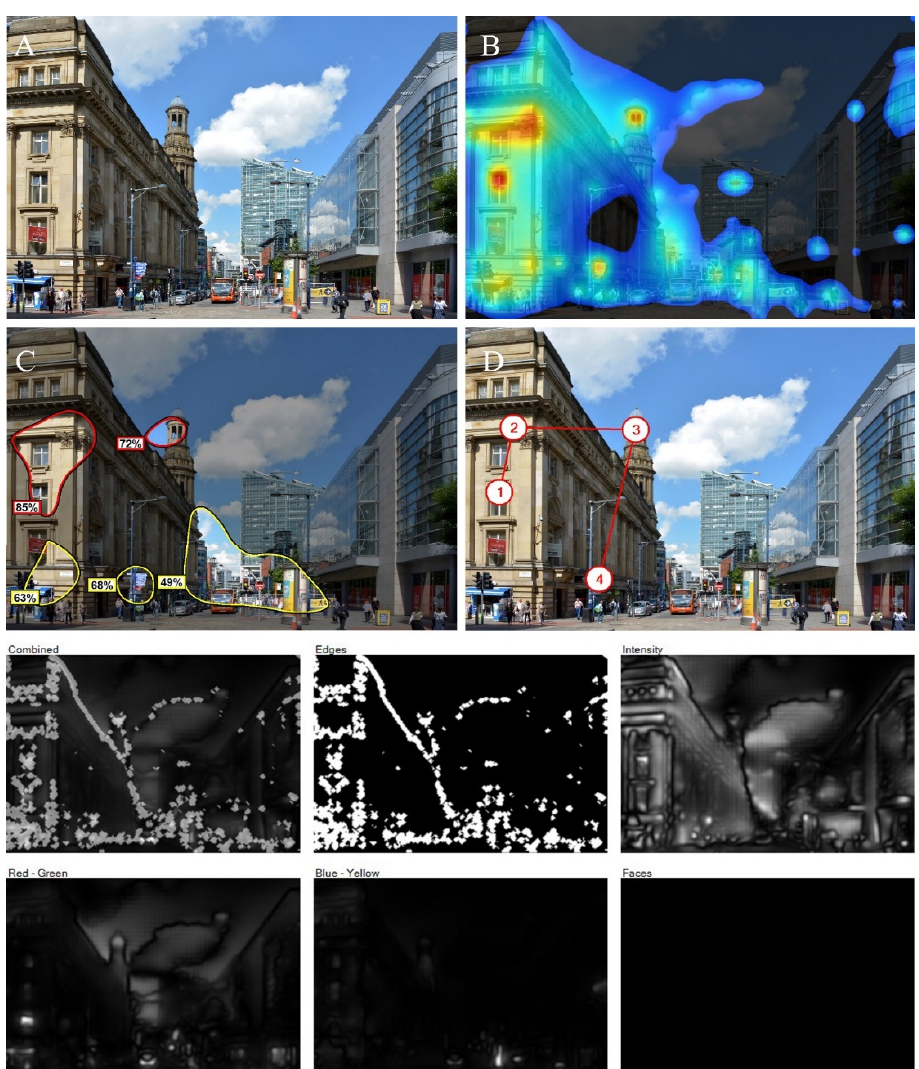
Figure 1. Image from the center of Manchester, UK, at the junction of Market and Cross Streets, with the full analysis output of the 3M-VAS software. ( A ): Original image. ( B ): Heatmap. ( C ): Simplified version of the heatmap results, showing only areas that are most likely to be seen within the 3–5 s first glance time period. ( D ): Gaze sequence of the four most likely gaze locations, in their most probable viewing order. The bottom six images register the 3M-VAS simulation of human pre-attentive gaze determining factors: edges, intensity, red/green color contrast, blue/yellow color contrast, and faces.